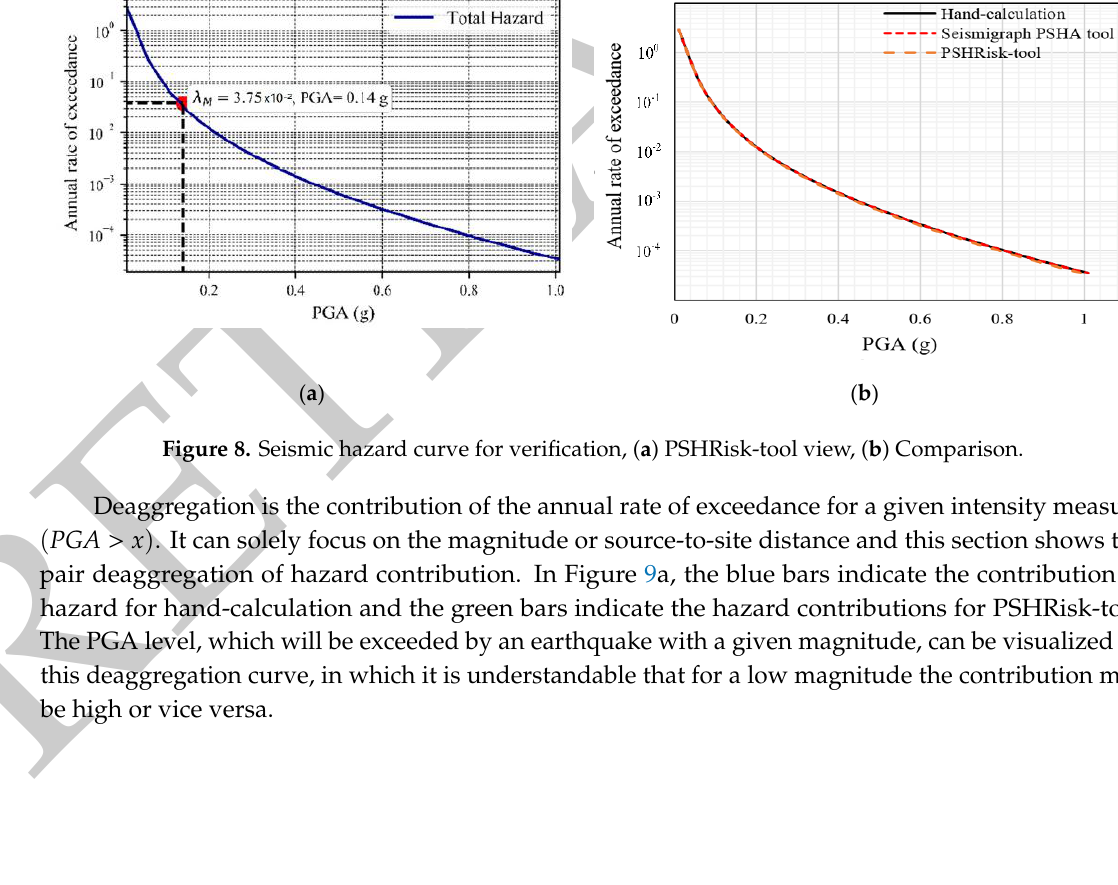
Figure 7. Verification for the probability distribution of magnitude with truncated Gutenberg-Richter relationship, ( a ) PSHRisk-tool view, ( b ) Comparison.